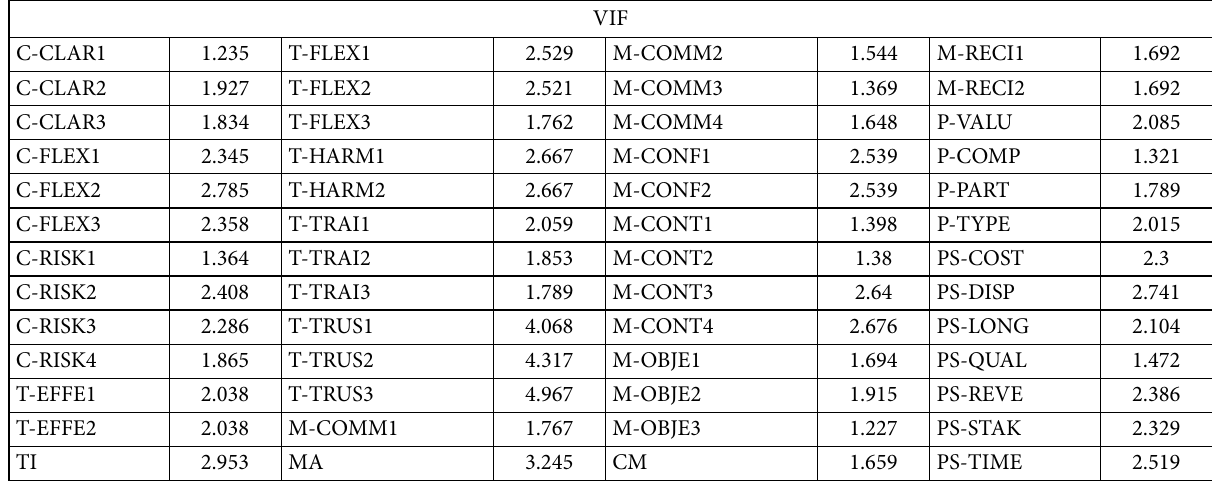
Table 5. Collinearity values for LOCs and HOCs